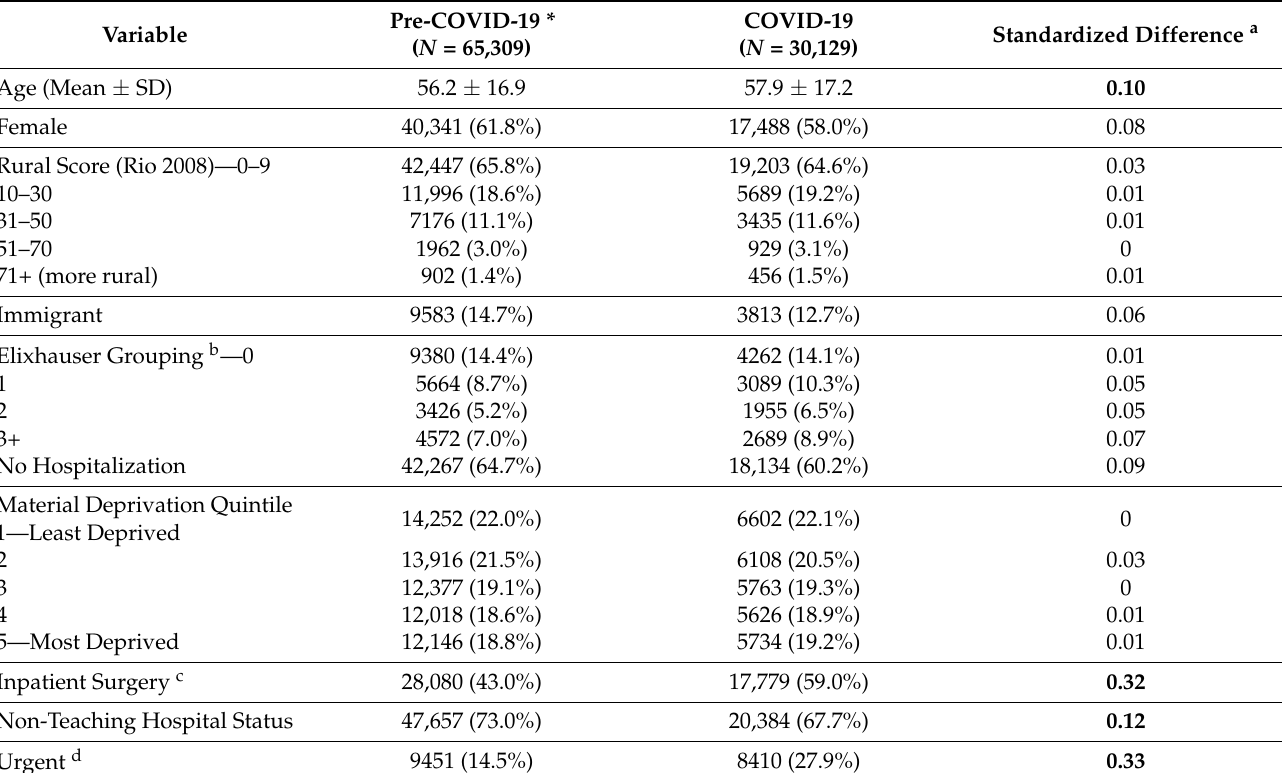
Table 1. Distributions of sociodemographic and hospital characteristics for surgeries performed during the pre- and COVID-19